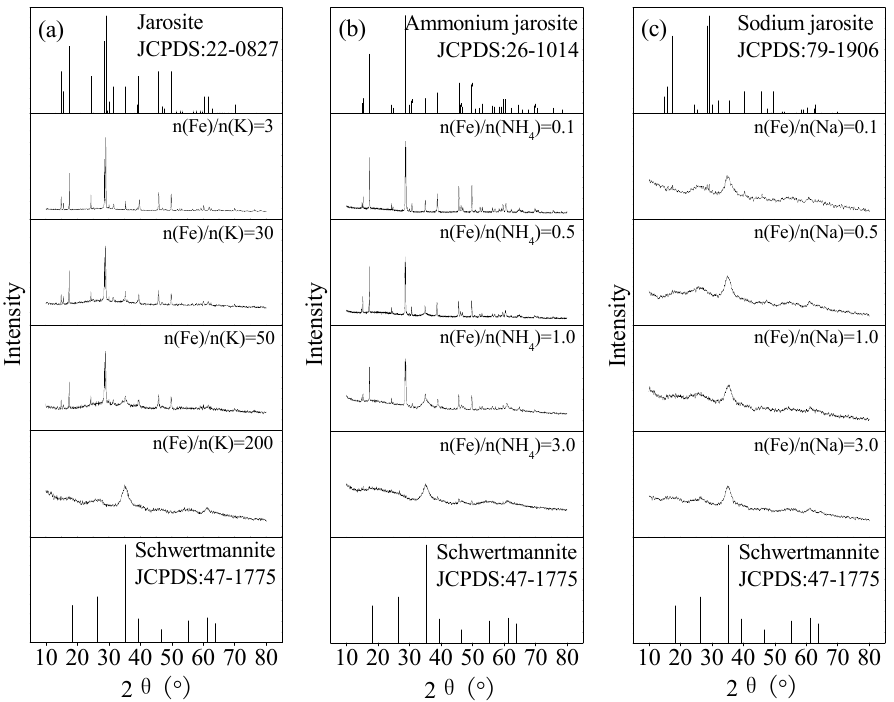
Figure 3. XRD patterns of precipitates formed through Fe 2+ oxidation by A. ferrooxidans under different n(Fe)/n(M) ratios (M: K, NH 4 , Na): ( a ) n(Fe)/n(K); ( b ) n(Fe)/n(NH 4 ); ( c ) n(Fe)/n(Na).